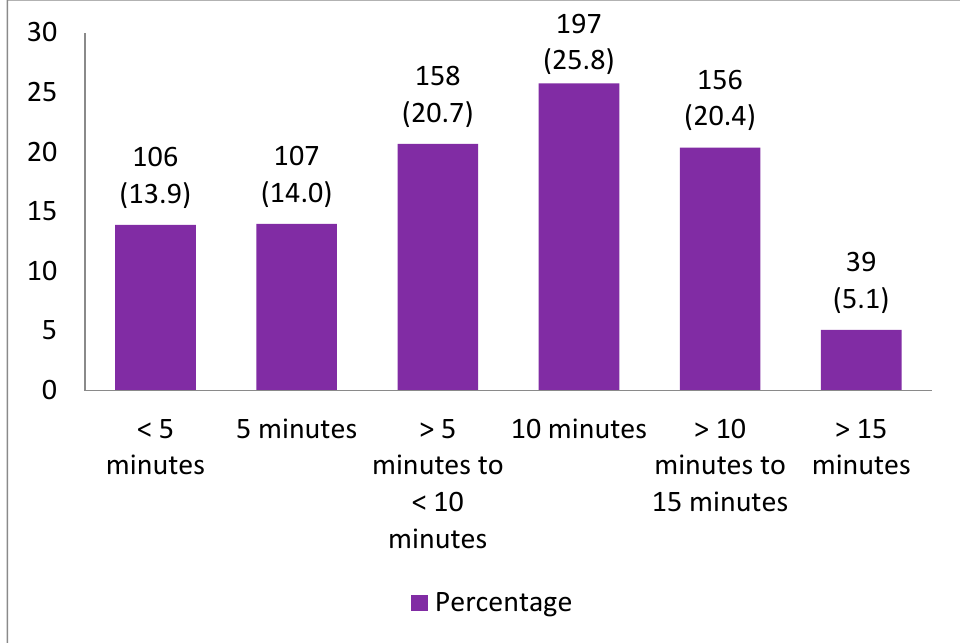
Figure 1. Percentage distribution of appointment length of medical consultations.